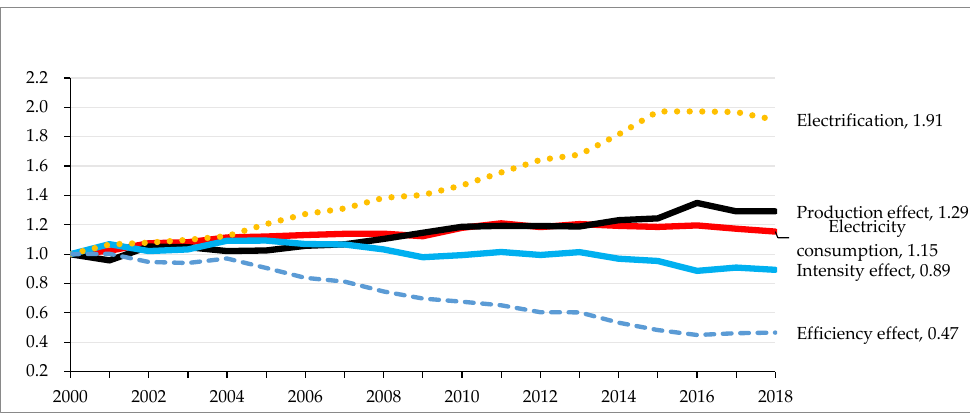
Figure A3. Wood and pulp electricity consumption LMDI results (fixed base year, multiplicative).